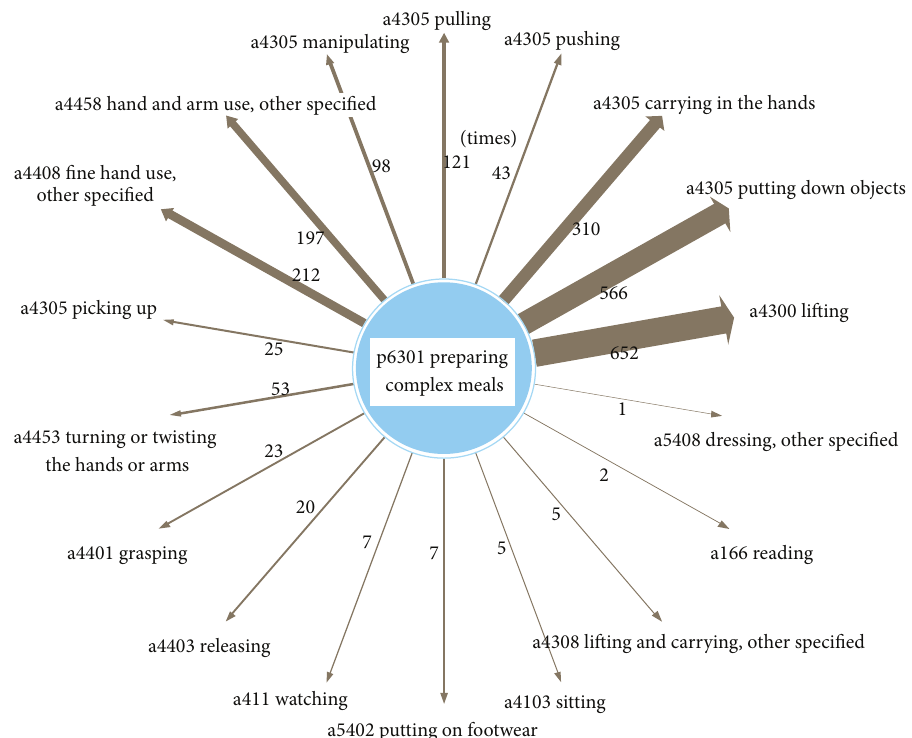
Figure 5: Activities included related with “preparing complex meals”